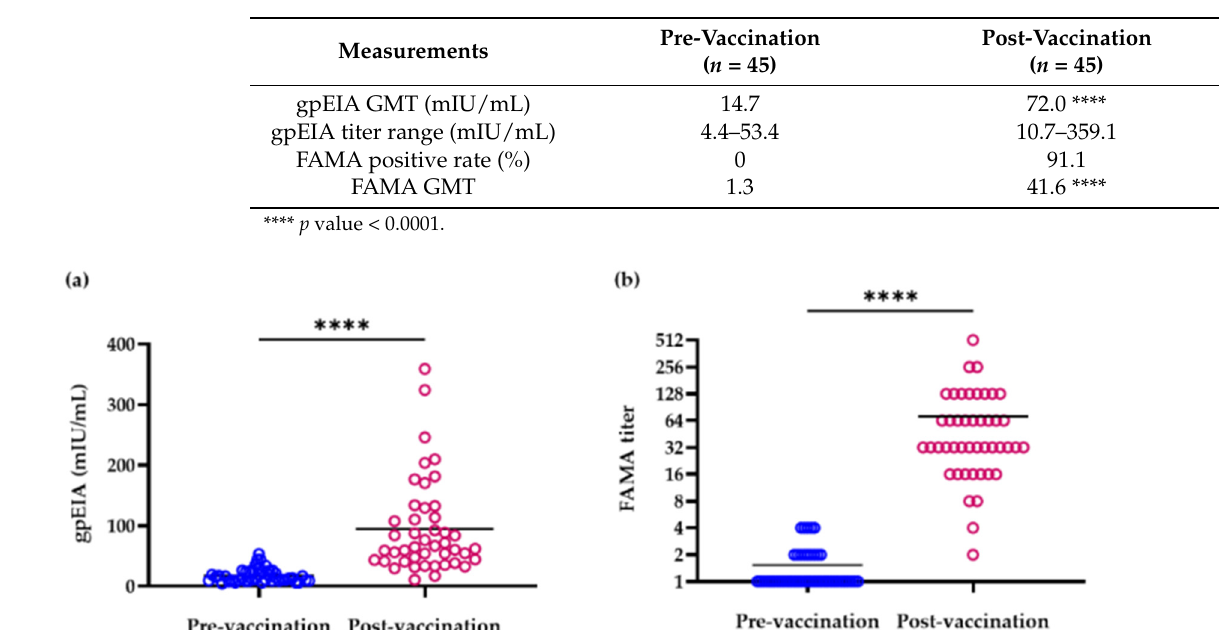
Table 3. gpEIA and FAMA results of vaccine study paired sera in 1-year-old children.